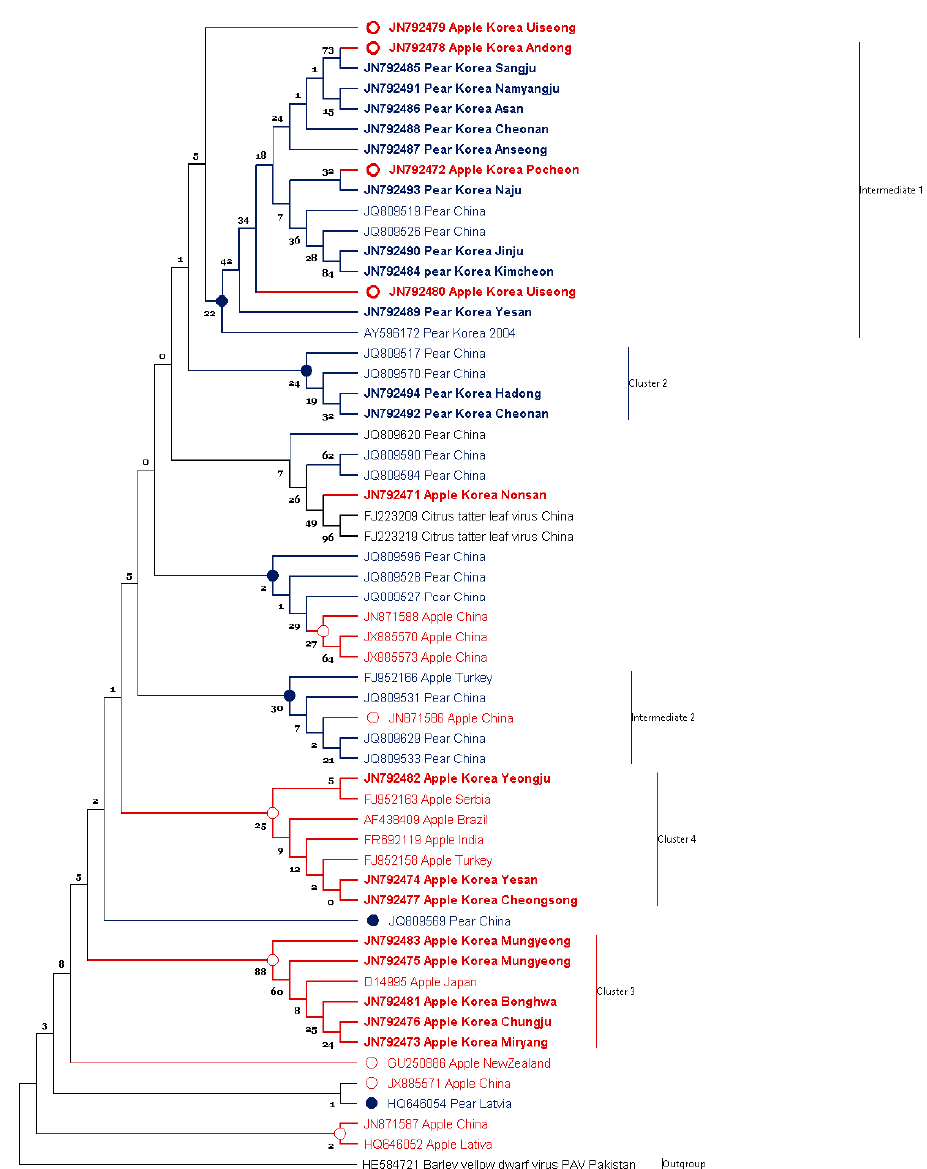
Figure 5. Phylogenetic analysis of apple stem grooving virus (ASGV) coat protein amino acid sequences. The tree was divided into distinct and intermediate clades. The Korean isolates identified in this study are shown with bold. Taxon names are color coded by isolation host (red for apple and blue for pear). The bootstrap support value is displayed on each branch node. The tree was generated using Maximum Likelihood with JTT+G best-fit-model implemented in MEGAX.